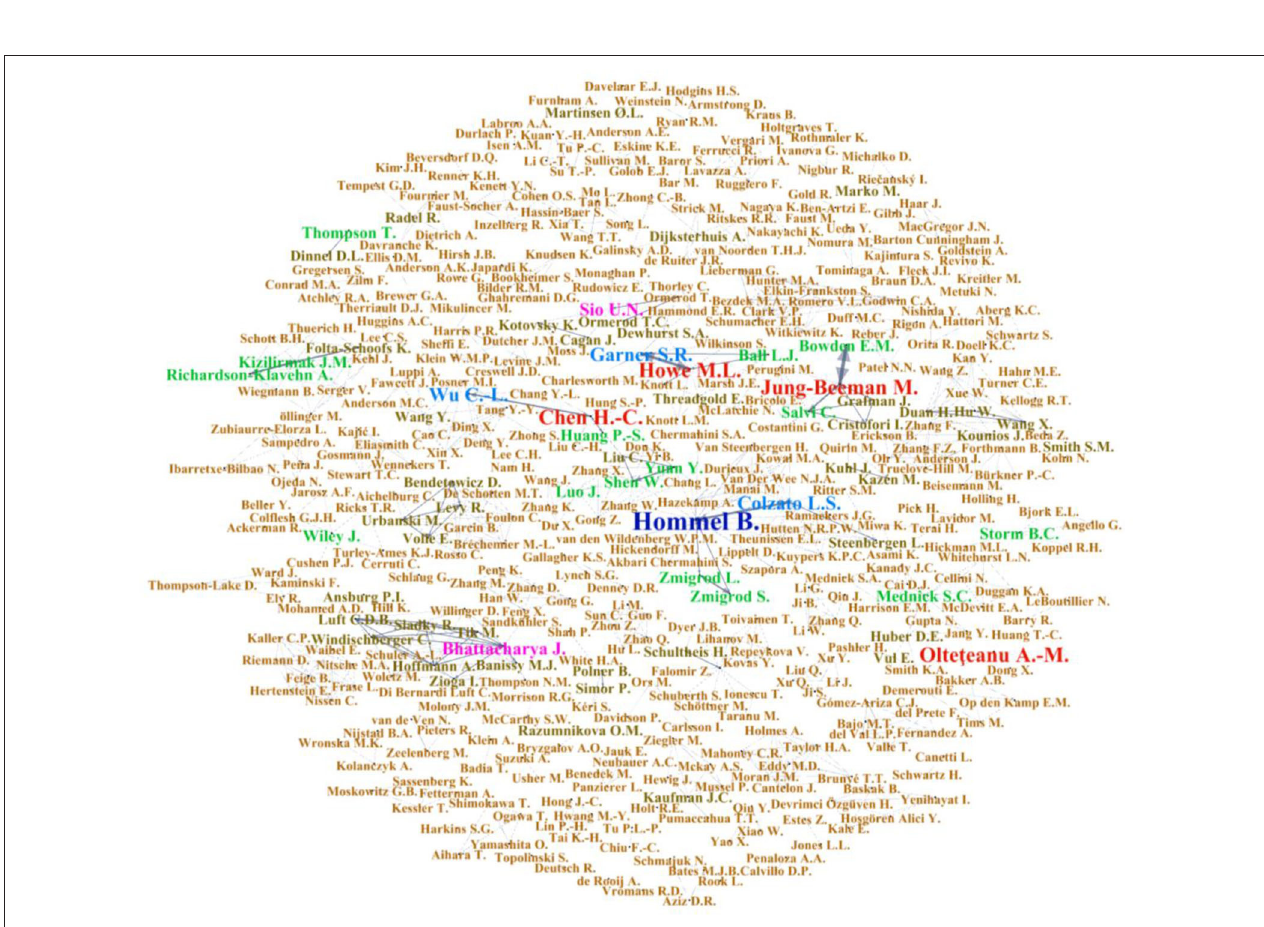
FIGURE 4 | Collinear network map of authors of creativity-related research using the remote association test from 2000 to 2019.